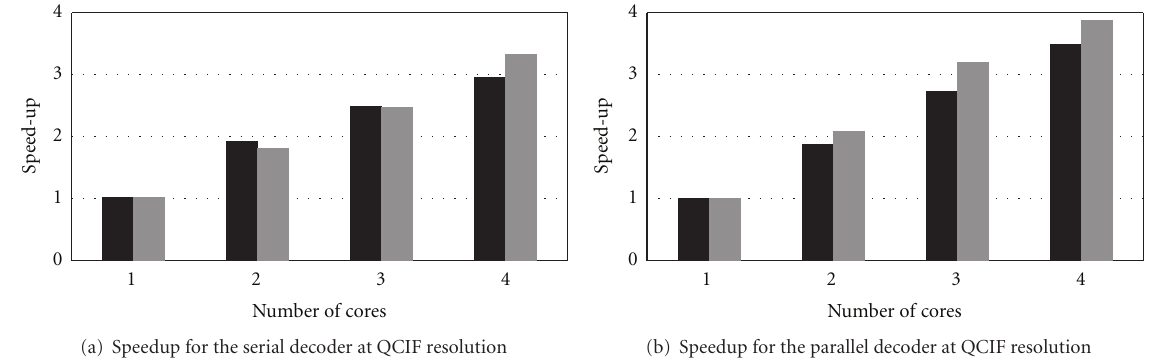
Figure 10: Speedup of the MPEG-4 SP decoder running on an X86 quad-core (in black) and on a PowerPC e500 8-core (in gray) processors.